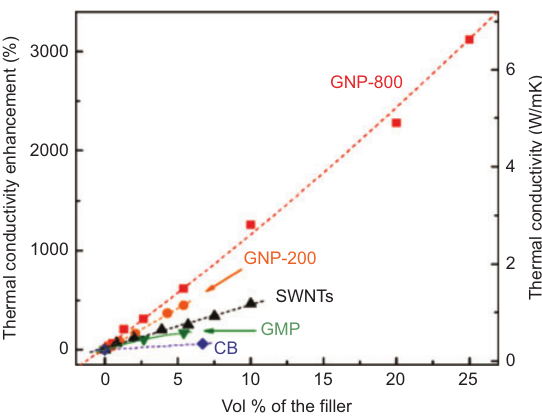
Figure 8 Thermal conductivity enhancement of epoxy-based com- posites at 30 ° C. Graphitic microparticles (GMP), GNPs exfoliated at 200 ° C (GNP-200) and 800 ° C (GNP-800), carbon black (CB), and purifi ed SWNTs. (Reproduced from Ref. [80] with permission from the American Chemical